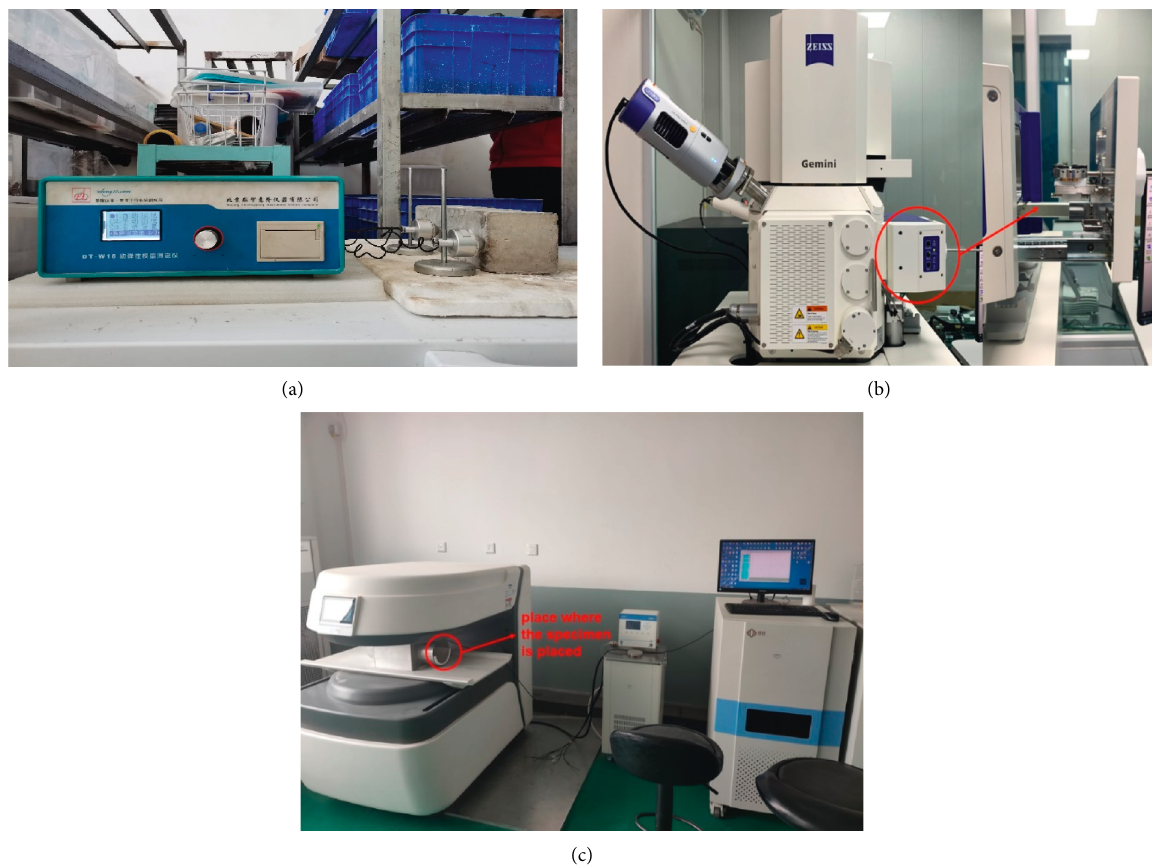
Figure 5: RDEM, NMR, and SEM test instruments: (a) dynamic elastic modulus tester; (b) SEM; (c) NMR.